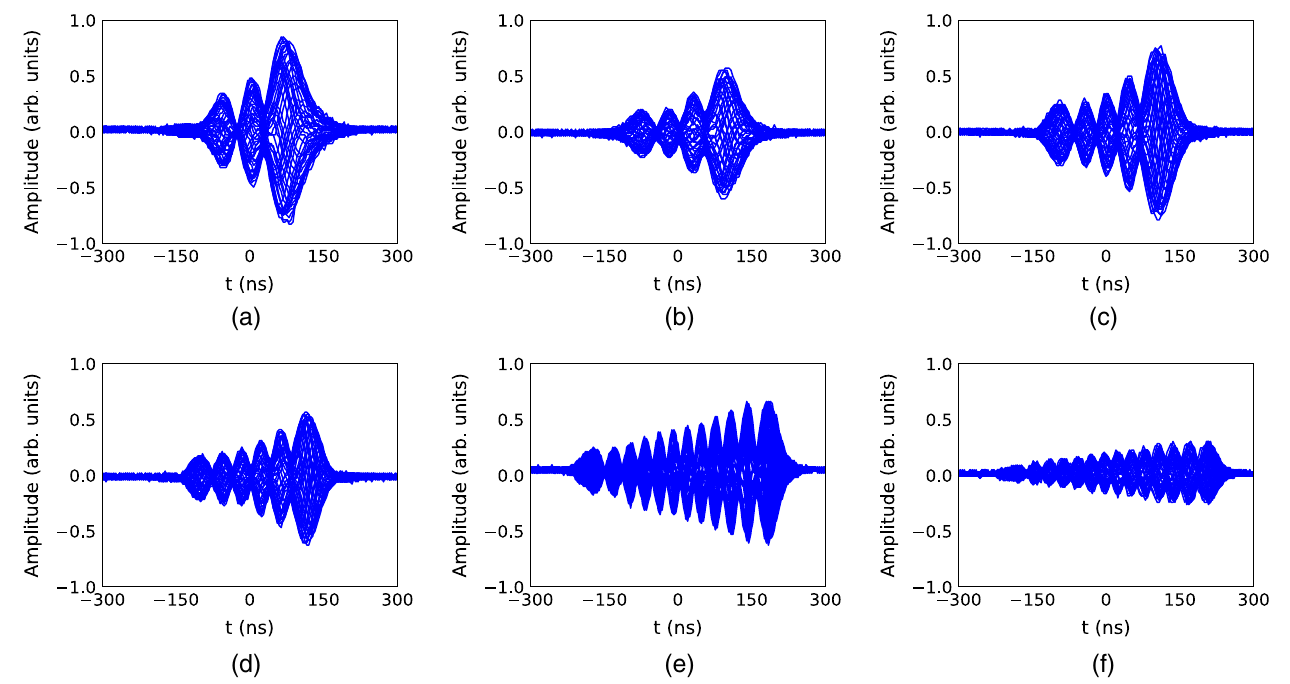
FIG. 6. Head-tail modes as recorded by the horizontal pick-up for a single bunch in the PSB and horizontal tune of 4.28. For chromaticity ξ x close to the natural value, a radial mode m ¼ 2 is detected [Fig. 6(a)]. As chromaticity increases in absolute value, the radial mode number increases up to m ¼ 13 for the maximum sextupole strength [Fig. 6(f)]. The intensity is fixed at N ¼ 3 × 10 12 p for all cases. (a) ξ x ¼ − 0 . 7 , m ¼ 2 , (b) ξ x ¼ − 1 . 1 , m ¼ 3 , (c) ξ x ¼ − 1 . 3 , m ¼ 4 , (d) ξ x ¼ − 1 . 6 , m ¼ 5 , (e) ξ x ¼ − 2 . 5 , m ¼ 11 , (f) ξ x ¼ − 2 . 7 , m ¼ 13 Fig. 5 with macroparticle simulations using the P y HEADTAIL code (green) and are found to be in reasonable agreement.